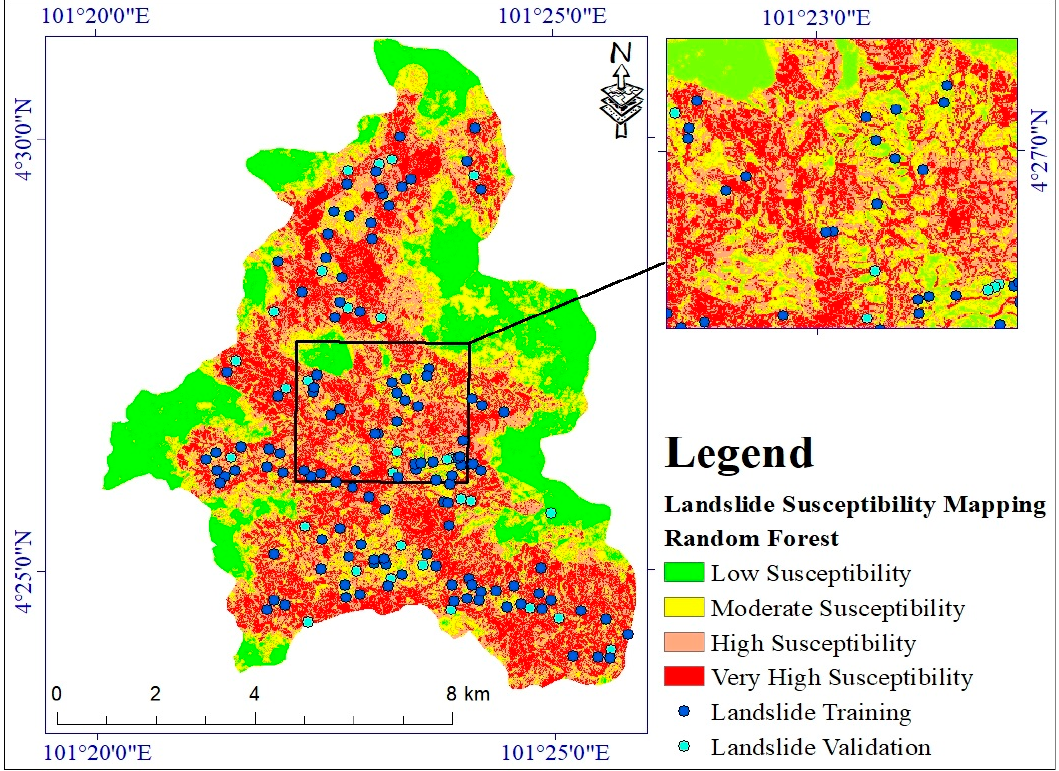
Figure 11. Landslide susceptibility map produced from the random forest (RF)